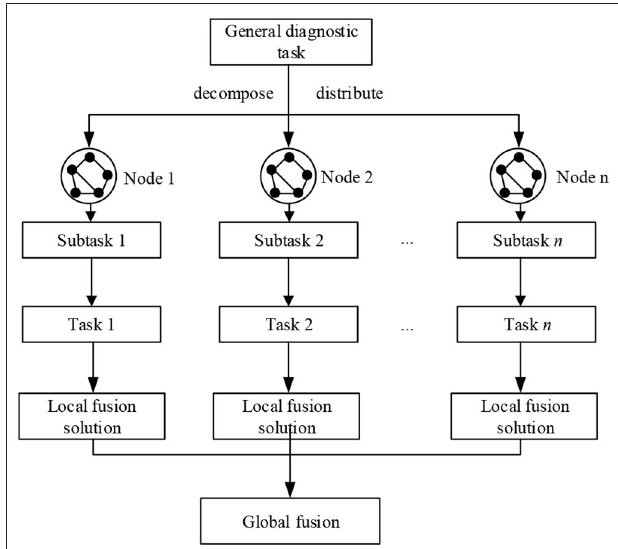
FIGURE 4 | Logic diagram of distributed fault diagnosis.